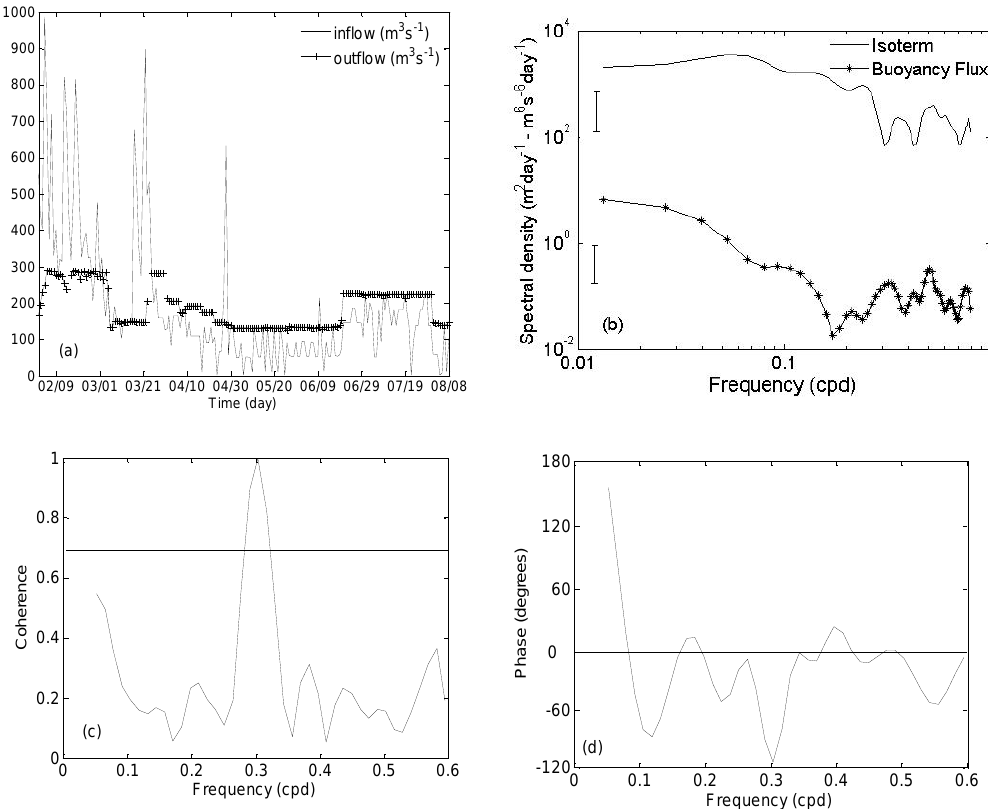
Fig. 6. (a) Inflow and outflow, (b) power spectra of the time evolution of the thermocline displacements and buoyancy flux smoothed by three Hanning passes (the 95% confidence interval is indicated), (c) coherence (the 5% level for zero coherence is indicated) and (d) the relative phase for the thermocline and buoyancy